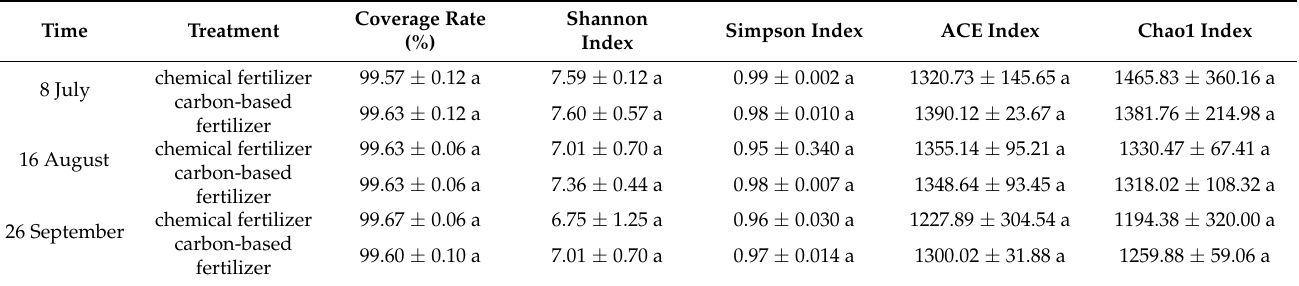
Table 7. α diversity of soil fungi treated with carbon-based fertilizer and chemical